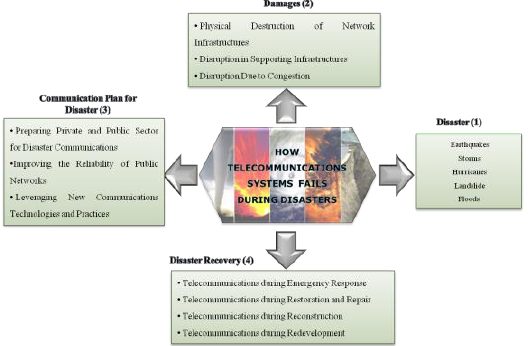
Figure 2. How the communications systems fail in